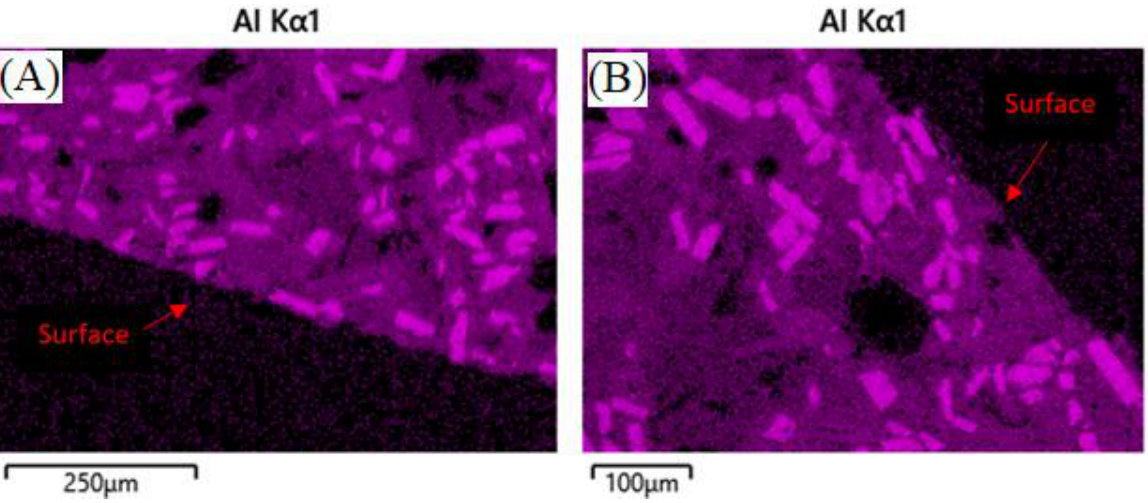
Figure 6. Surfaces of ASH-G composite after heating to 805 °C for 240 h without ( A ) and with ( B ) NaCl. No glaze is present in either case.